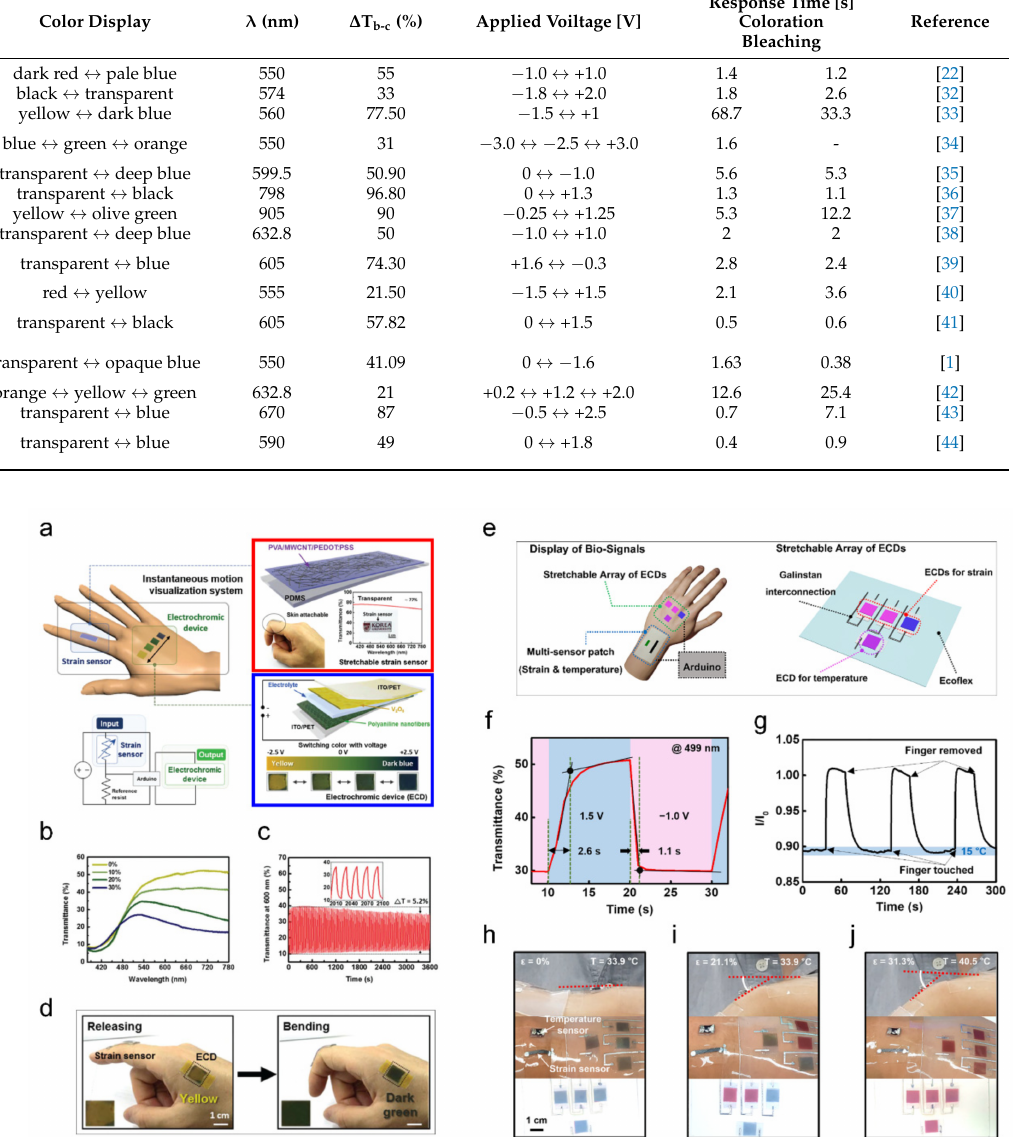
Figure 3. Electrochromic integrated strain sensor for visualization (( a – d ) adapted with permission from ref. [30], copyright 2017 The Royal Society of Chemistry, and ( e – j ) adapted with permission from ref. [31], copyright 2022 Elsevier). ( a ) Schematic and circuit diagram of an interactive color- changeable platform with an ECD integrated strain sensor. Strain sensors are composed of the PVA/MWCNT/PEDOT:PSS on a PDMS substrate with a transmittance spectrum (red box). ECD consists of a polyaniline nanofiber/electrolyte/V 2 O 5 with an ITO-coated PET film as an electrode, displaying a color change from yellow to dark upon application of a voltage (blue box). ( b ) Transmit- tance change under varied applied strain (0, 10, 20, and 30%). ( c ) Current-voltage curves of the strain sensor under various strain (10, 15, 20, and 30%). ( d ) Photograph of the ECD integrated strain sensor with finger motions. ( e ) Skin-attachable ECD array with strain and temperature sensor integration ( left ) and a stretchable array of ECDs ( right ). ( f ) Transmission change of the designed ECD under bias voltages at 499 nm. ( g ) Normalized current (I/I o ) variation by finger touch. Visual information of wrist bend and skin temperature from the skin-attached array of ECD color patterns varying under the applied strain ( ε ) and temperature (T): ( h ) T = 33.9 ◦ C; ε = 0%, ( i ) T = 33.9 ◦ C; ε = 21.1%, ( j ) T = 40.5 ◦ C; ε =